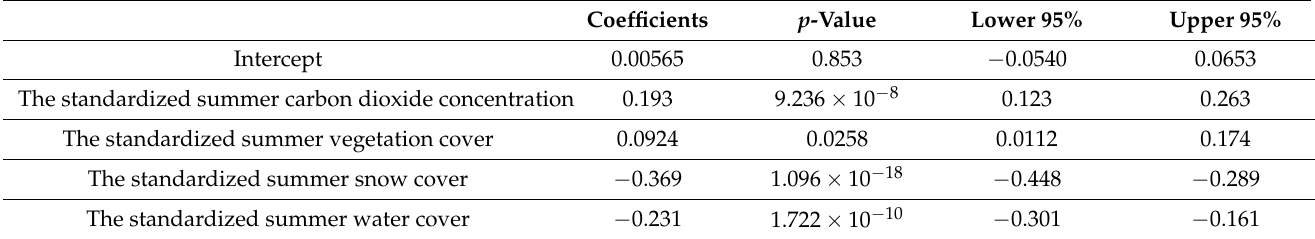
Table 9. T -test for each parameter